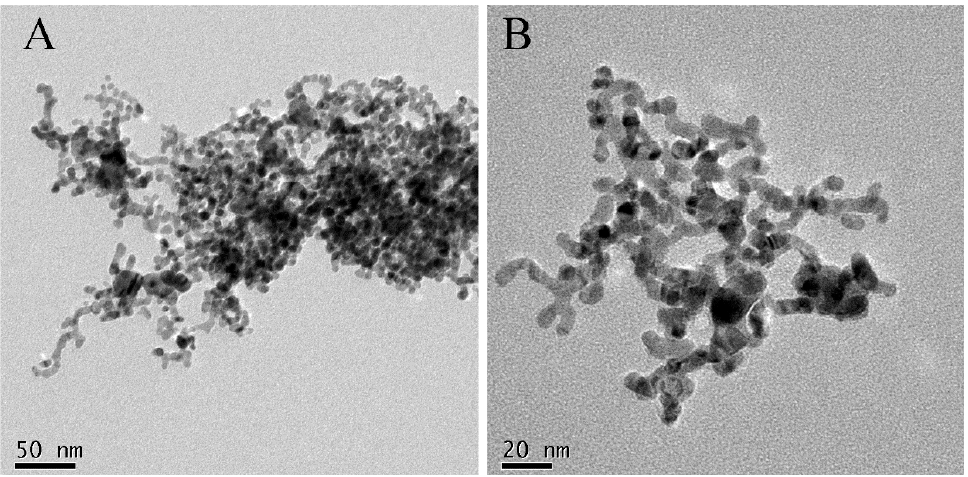
Figure 2. TEM images of the as-synthesized PdAg catalysts with different magnifications.